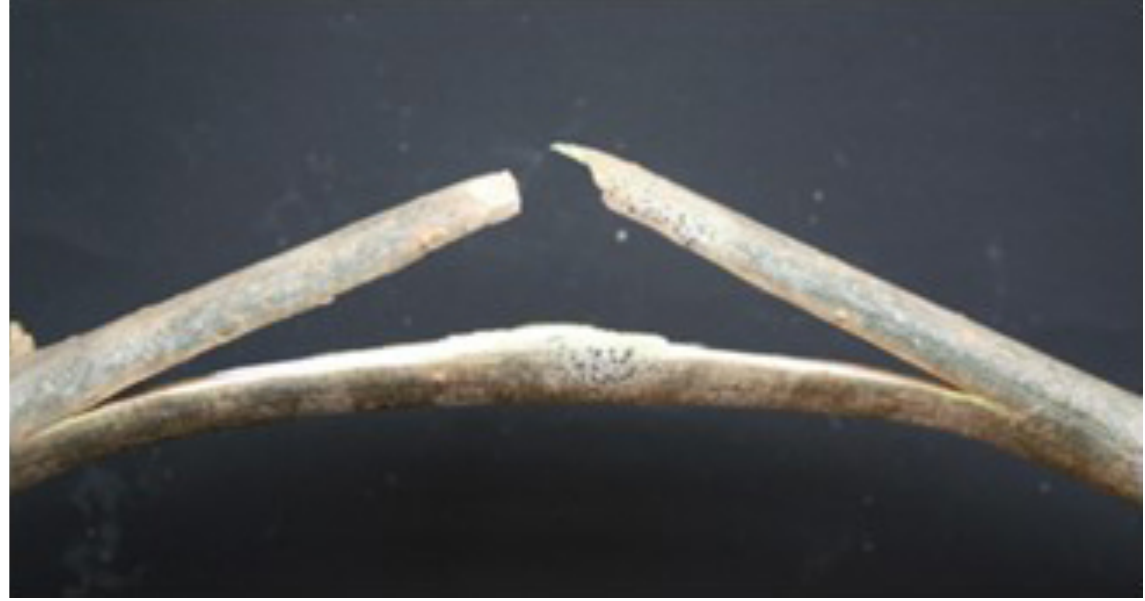
Figure 3. Greenstick fracture of a living branch of ash Fraximus excelsior showing splitting along the centre-